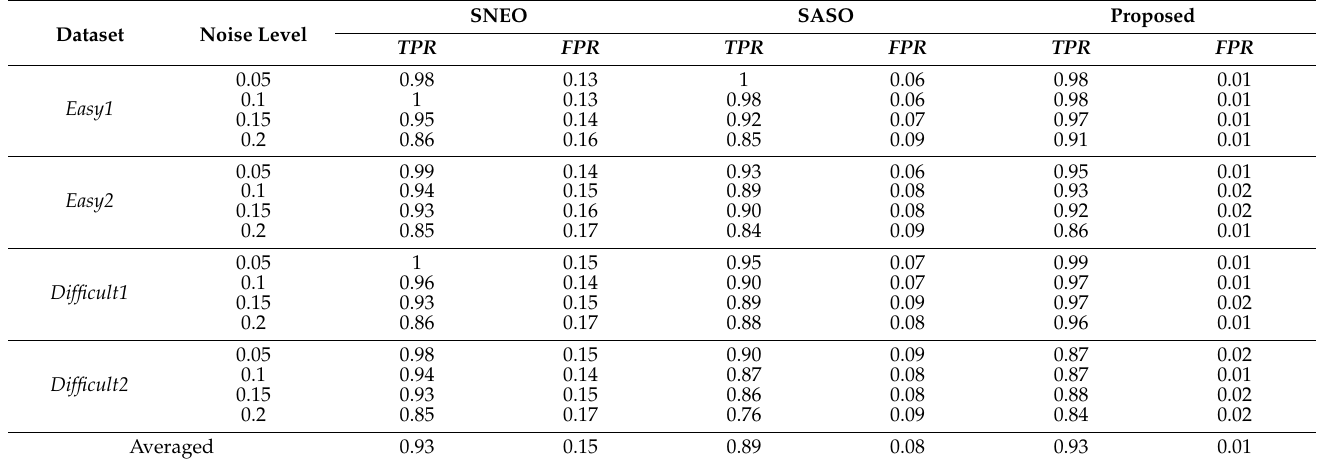
Table 1. Sensitivity and False Alarm Rate of studied spike detectors on a synthetic dataset.